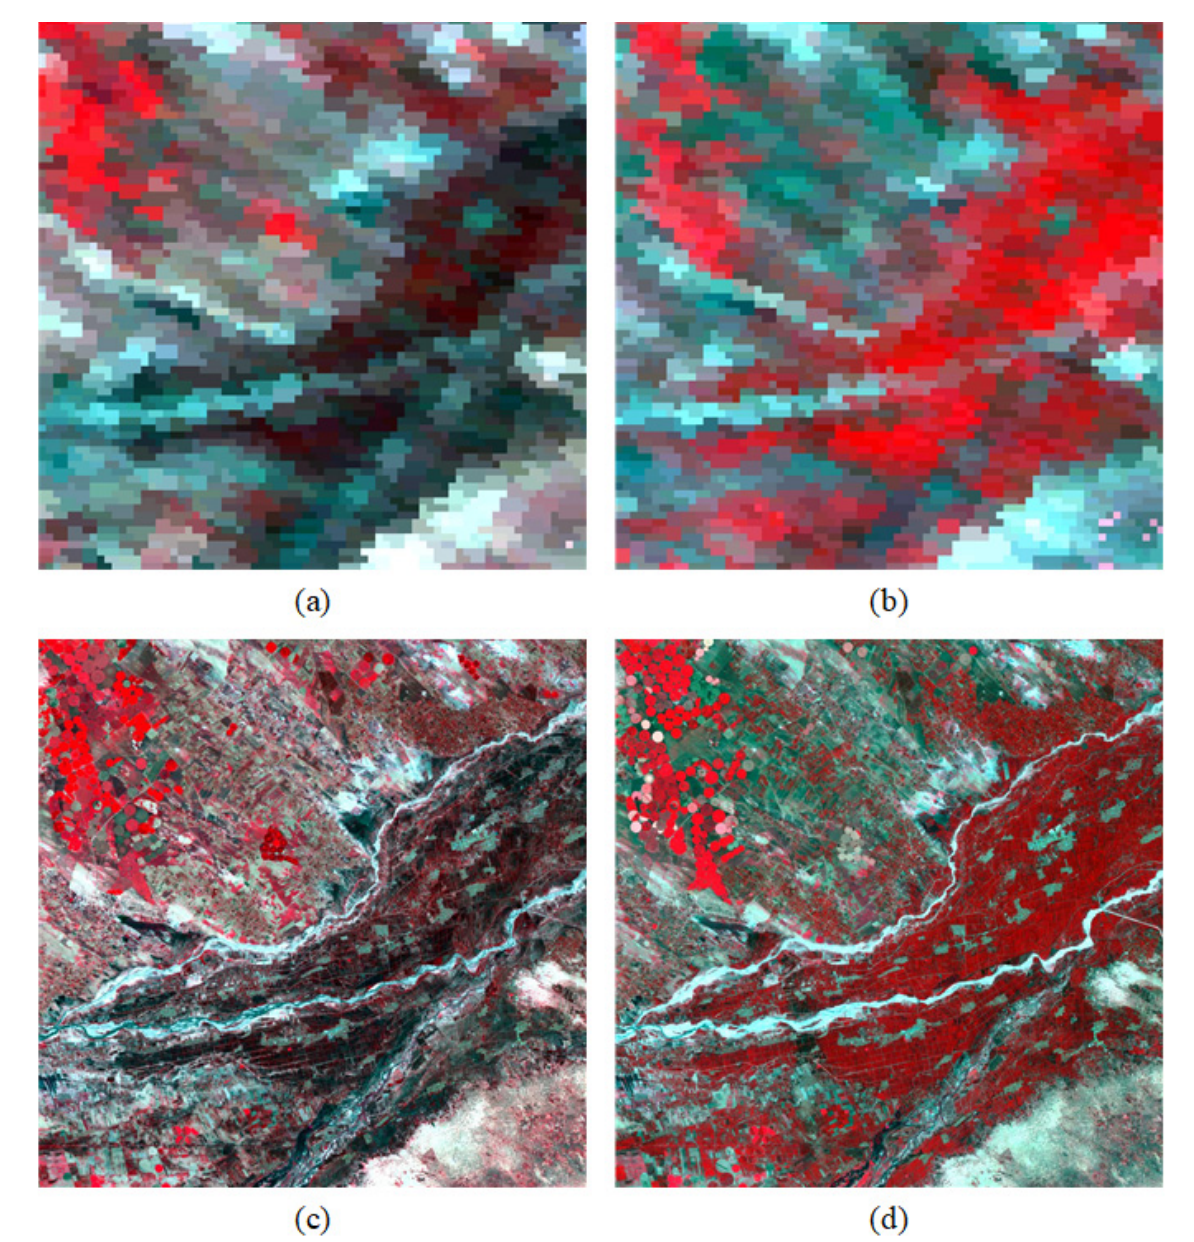
Figure 6. Composite MODIS ( top row ) and Landsat ( bottom row ) image pairs on 21 June ( a , c ) and 7 July ( b , d ) 2015 from the AHB [45,46] dataset. The AHB focuses on noteworthy phenological changes in the pasture.